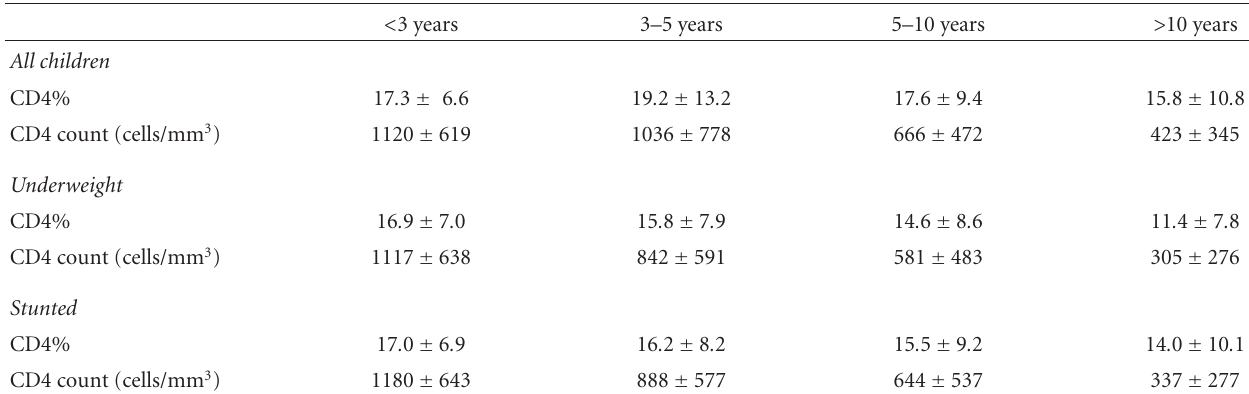
Table 3: Mean CD4% and CD4 cell count of children in di ff erent age groups as well as in those with underweight and stunting.